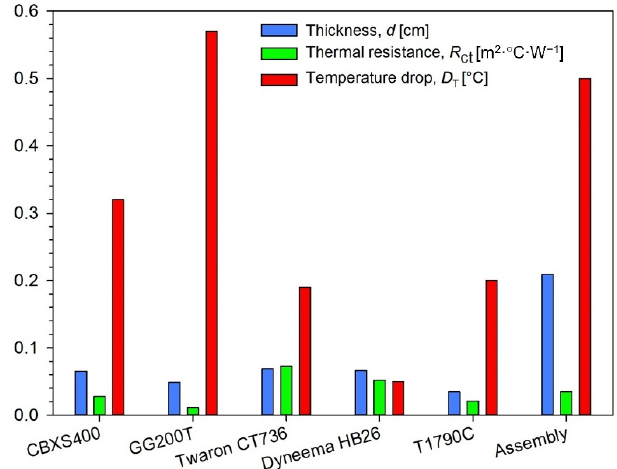
Figure 8. Comparison textile thickness, thermal resistance and simulated temperature drop. Temperature distributions on 3D models of tested five textiles and the assembly were presented in Figure 9. In the case of CBXS400, Twaron CT736, Dyneema HB26, T1790C and assembly the entire volume of the model, a uniform temperature drop can be seen with the distance from the hotplate. For these models, the temperature is the same over the entire top surface. In the case of the GG200T woven fabric one can observe heterogeneous temperature distribution due to the large spaces between the weft and warp yarns and the asymmetrical 2 × 2 twill weave and it is possible to observe areas with different temperatures located at the same distance from the hotplate.